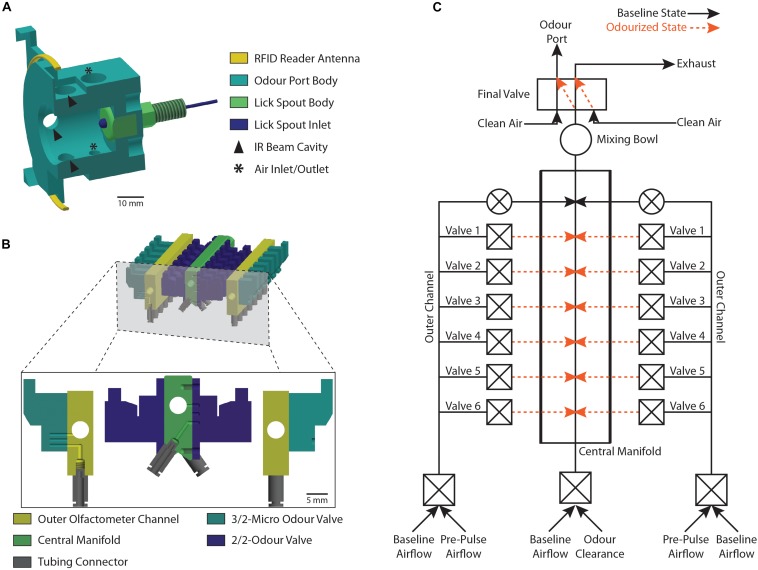
Schematic representation of the odor port and the olfactometer. (A) Cross-section view of the 3D printed odor port (light blue) showing the location of the RFID reader antenna (yellow) and the lick spout (dark blue and green). Arrows denote the cavities housing the IR beam LEDs and detectors while asterisks denote the position of the air-flow inlet and outlet. (B) Cross-section view of the olfactometer showing the location of the central manifold (green) and the two outer channels (yellow). The odor reservoirs are connected to the individual olfactometer parts using tubing connectors (gray) and are gated by two odor valves (light and dark blue) per reservoir. (C) Schematic representation of the olfactometer as shown in (B) highlighting the individual air-flow pathways. Each Valve ID (Valve 1–Valve 6) corresponds to the pair of valves gating a particular odor reservoir. Black lines show the baseline air-flow pathway when no odor is applied while orange lines represent the air-flow pathway during application of an odor. Constant flow of clean air is maintained through normally open valves (round valves) while odor application is gated through normally closed valves (square valves).